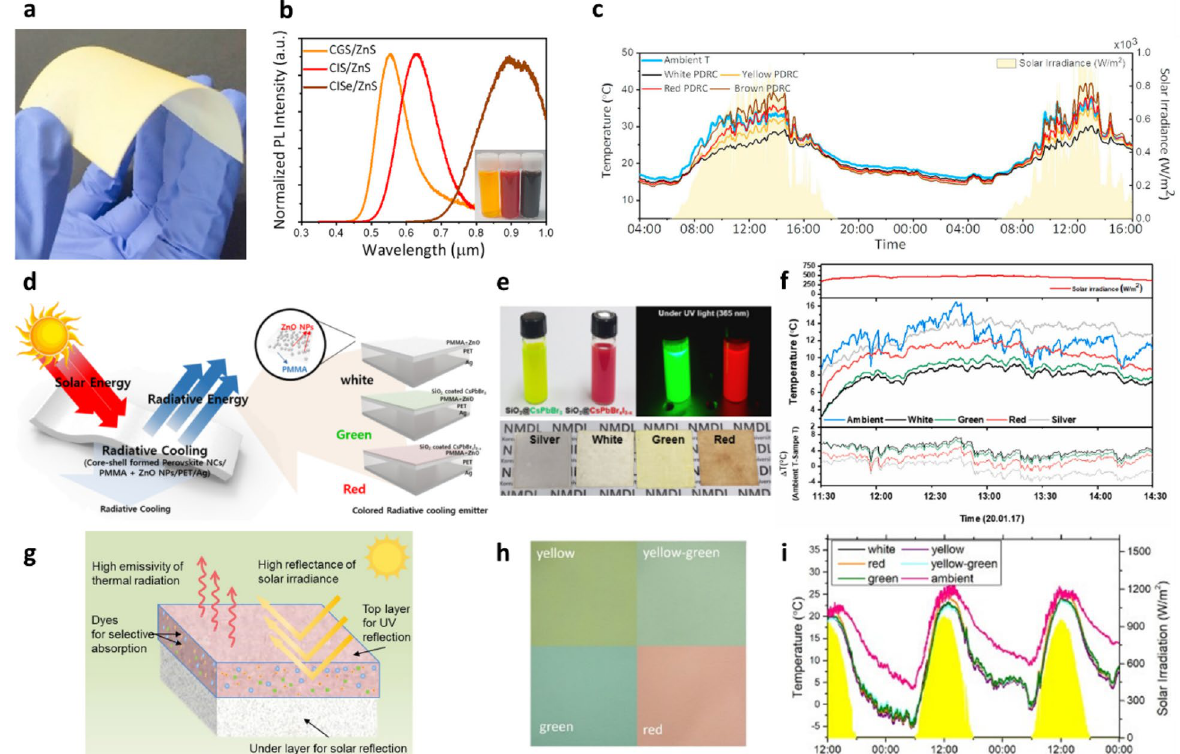
Fig. 6 a Photograph of yellow PDRC film coating on a flexible substrate. b Normalized PL spectra and photographs of CuGaS 2 @ZnS, CuInS 2 @ ZnS, and CuInSe 2 @ZnS core-shell QD solutions. c Temperature profiles of white, yellow, red, and brown PDRC films compared to the ambient temperature. Reproduced with permission from [74]. Copyright 2021, Elsevier. d Schematic of colored RCMs with silica-embedded perovskite NCs/PMMA ZnO/PET/Ag films. e Photos of perovskite NCs in hexane and colored RCM films. f Daytime temperature profiles of colored RCMs. + Reproduced with permission from [81]. Copyright 2021, Elsevier. g Schematic illustration and h photographs of colored RC coatings with a bilayer structure. i Outdoor temperature profiles of colored RC coatings compared to the ambient temperature. Reproduced with permission from [92]. Copyright 2022,